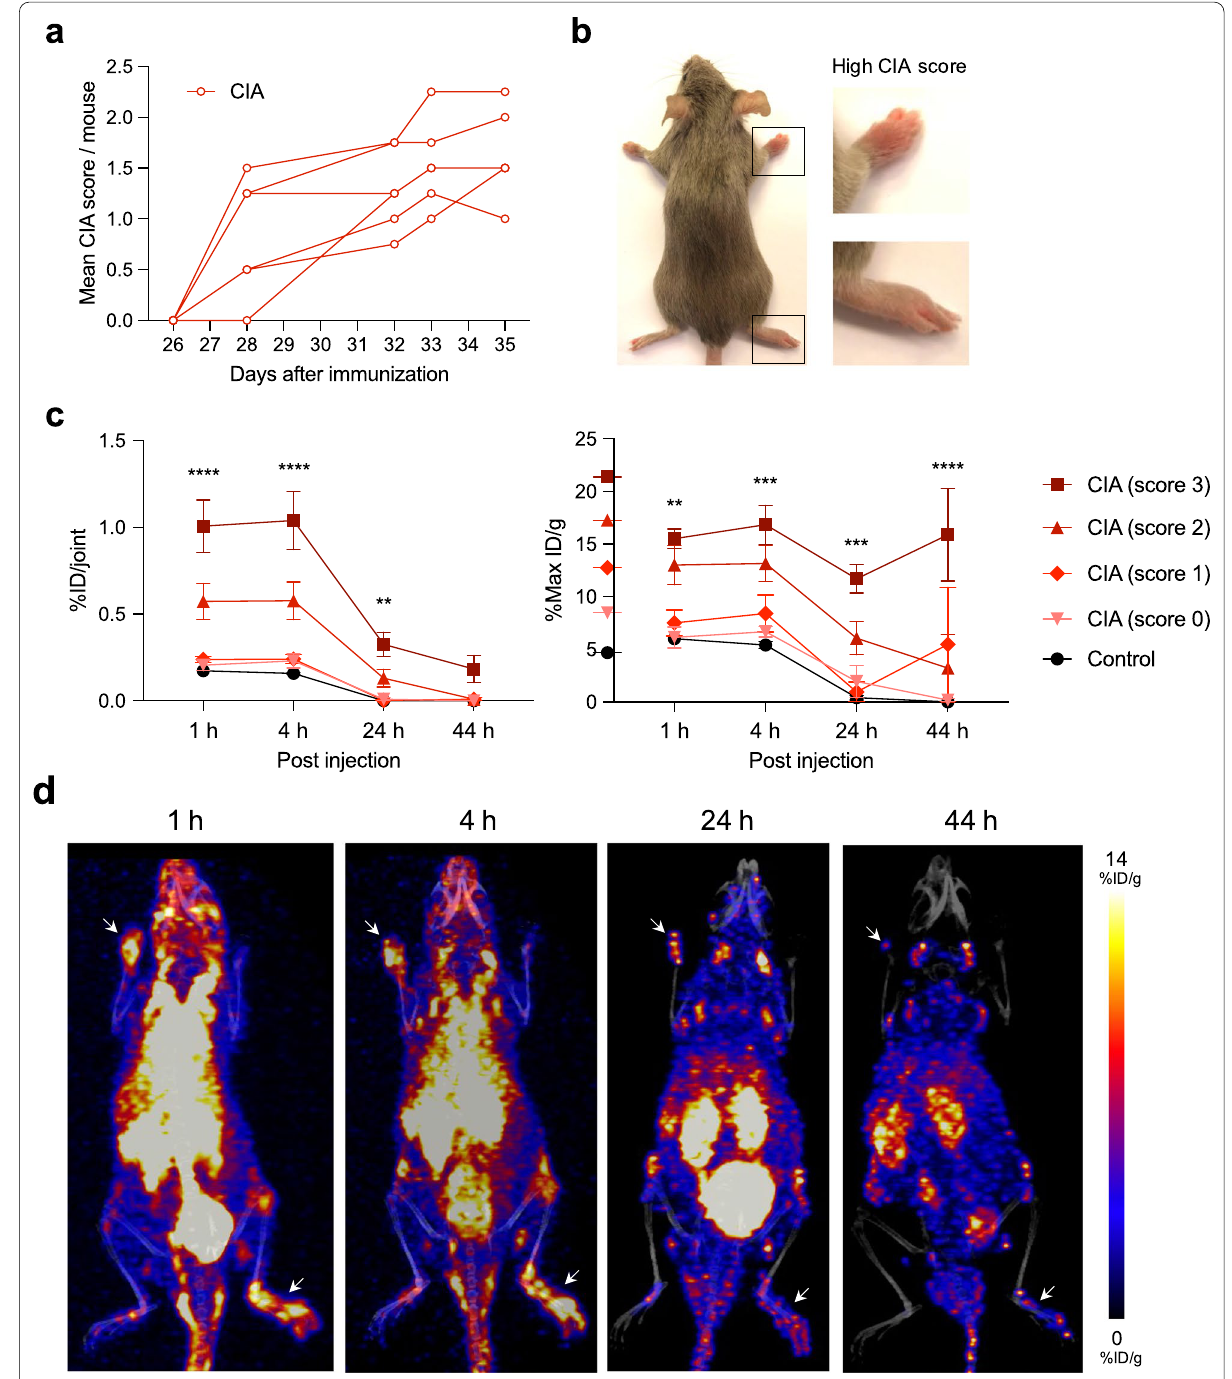
Fig. 2 Characterization of the collagen-induced arthritis (CIA) mouse model and [ 64 Cu]Cu-NOTA-CD4 uptake in joints. a CIA mice were scored according to degree of inflammation (swelling and erythema) in each paw on a scale from 0 to 4 (n mouse starting on day 26 after immunization to the last day of PET/CT imaging where the mice were euthanized (day 35). Each line represents the development of arthritis in one mouse. b Representative images of a CIA mouse on day 35 with pronounced arthritis in right carpal and tarsal joints. c [ 64 Cu]Cu-NOTA-CD4 uptake per joint (%ID/joint) and maximum activity (%Max ID/g) in carpal and tarsal joints of CIA mice ( n mice ( n 4) at 1, 4, 24 and 44 h p.i. Asterisks (*) represent statistical significance between controls and mice with high CIA score (score 3). Data = are presented as mean SEM. (*). p < 0.01 (**), p < 0.001 (***) and p < 0.0001 (****). d Representative maximum intensity projections (coronal view) ± of a CIA mouse with pronounced arthritis (score 3) in left carpal and right tarsal joint at 1, 4, 24 and 44 h p.i. of [ 64 Cu]Cu-NOTA-CD4. White arrows indicate lesion sites with score